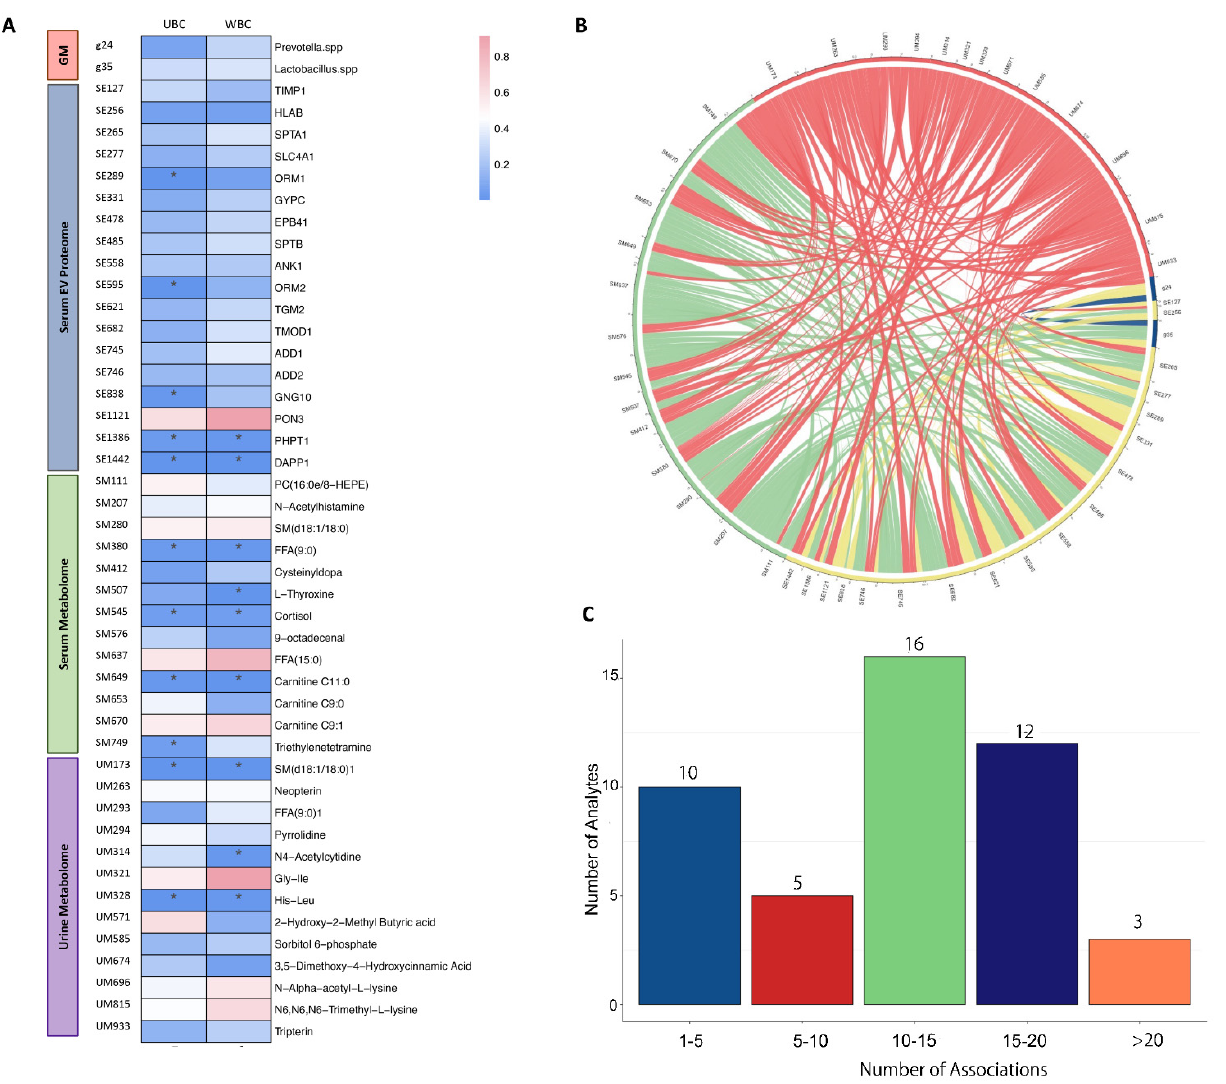
Figure 4. Interactive analysis of identified multi-omics biomarkers. ( A ) Correlation of identified analytes with unconjugated bilirubin and white blood cell count; ( B ) Correlation between each pair of identified analytes; ( C ) The number of correlations of each analyte to others. Abbreviations: UBC, unconjugated bilirubin; WBC, white blood cell count; His-leu, Histidine-Leucine; Gly-Ile, Glycyl- Isoleucine; FFA (9:0), Nonanoic acids; SM (d18:1/18:0), Sphingomyelin; FFA (15:0), Pentadecylic acid; DAPP1, Dual adapter for phosphotyrosine and 3-phosphotyrosine and 3-phosphoinositide; PHPT1, 14 kDa phosphohistidine phosphatase; PON3, Serum paraoxonase/lactonase 3; GNG10, Guanine nucleotide-binding protein G(I)/G(S)/G(O) subunit gamma-10; ADD2, Beta-adducin; ADD1, Alpha-adducin; TGM2, Protein-glutamine gamma-glutamyltransferase 2; ORM2, Alpha-1- acid glycoprotein 2; ANK1, Ankyrin-1 OS = Homo sapiens ; SPTB, Spectrin beta chain non-erythrocytic 1; EPB41, Protein 4.1 OS = Homo sapiens ; GYPC, Glycophorin-C OS = Homo sapiens ; ORM1, Alpha-1- acid glycoprotein 1; SLC4A1, Band 3 anion transport protein; SPTA1, Spectrin alpha chain erythro- cytic 1; HLAB, HLA class I histocompatibility antigen B alpha chain; Metalloproteinase inhibitor 1. * p < 0.05.